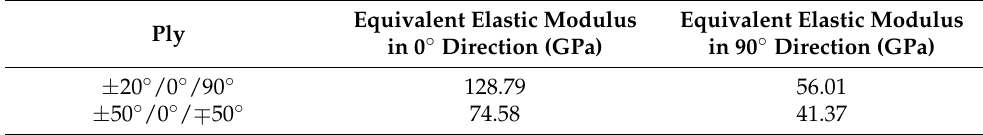
Table 3. The elastic modulus of the plane in two main